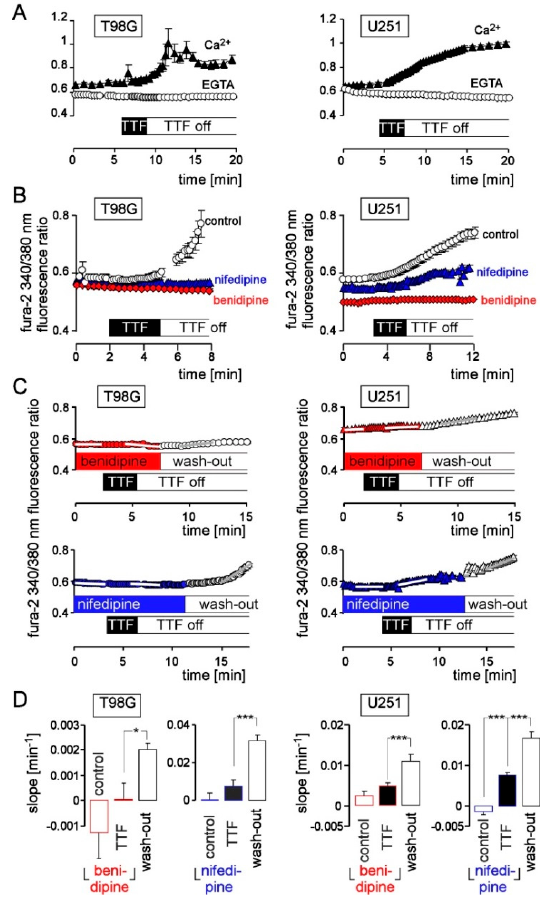
Figure 4. TTFields induce a dihydropyridine-sensitive Ca 2+ -entry in human glioblastoma cells. ( A ) Time course of TTFields (200 kHz, 2.5 V/cm, 3 min)-induced changes of mean (± SE; n = 8–20) fura-2 340/380 nm fluorescence ratio as recorded in T98G (left) and U251 (right) cells with Ca 2+ (1 mM)-containing NaCl-solution (closed triangles) and EGTA (0.6 mM)-buffered Ca 2+ -free NaCl-solution (open circles). ( B ) Mean (± SE; n = 13–20) fura-2 340/380 nm fluorescence ratio recorded in T98G (left) and U251 cells (right) before, during, and after application of TTFields (200 kHz, 2.5 V/cm, 3 min) during continuous superfusion with Ca 2+ -containing NaCl-solution (open circles), Ca 2+ -containing NaCl solution further containing 1 µM benidipine (red triangles) or 1 µM nifedipine (blue diamonds). ( C ) Mean (± SE; n = 13–39) fura-2 340/380 nm fluorescence ratio recorded in T98G (left) and U251 cells (right) before, during, and after application of TTFields (200 kHz, 2.5 V/cm, 3 min) during continuous superfusion with benidipine (1 µM, top, red symbols) or nifedipine (1 µM, bottom, blue symbols)-containing NaCl-solution and after wash-out of the inhibitors (open symbols). ( D ) Mean (± SE; n = 34–63) slope (as indicated by white lines in ( C )) of the fura-2 340/380 nm fluorescence ratio changes before (control), at the end and shortly after TTF-application (middle) both in the presence of benidipine (red) or nifedipine (blue) as well as after wash-out of the inhibitors. * and *** in ( D ) indicate 3 p ≤ 0.05 and 3 p ≤ 0.01, respectively, (Welch)-corrected t -test and Bonferroni correction for 3 pairwise comparisons.